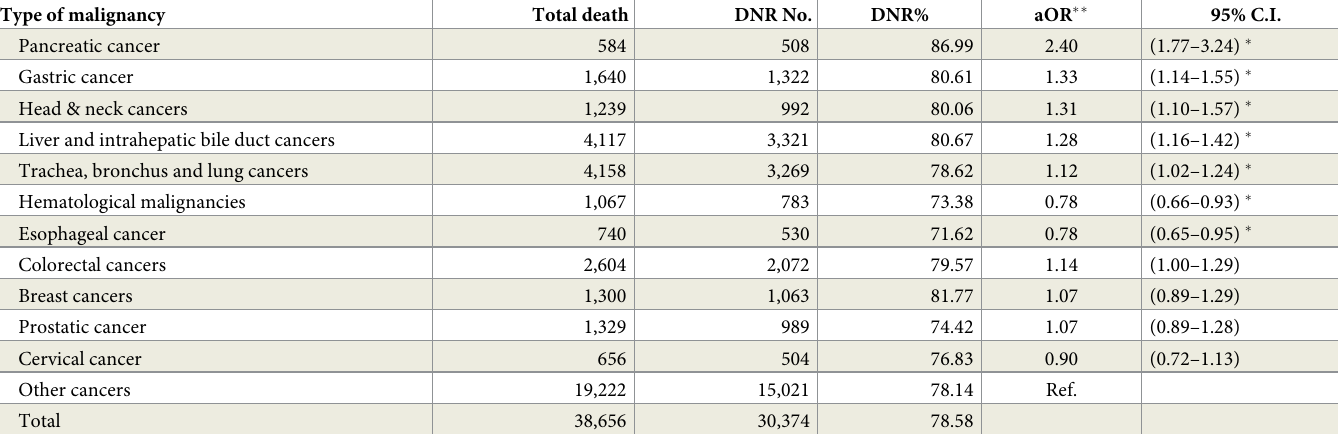
Table 1. Adjusted odds ratios (aOR) of do-not-resuscitate (DNR) rates in different type of cancer patients.